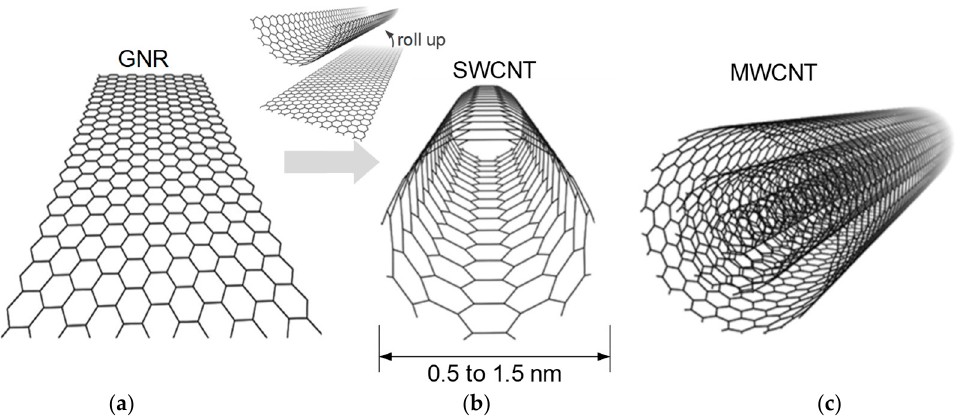
Figure 1. Schematics of ( a ) monolayer graphene nanoribbon (GNR), ( b ) single-walled carbon nanotube (SWCNT), and ( c ) multi-walled carbon nanotube (MWCNT). (SWCNT), and ( c ) multi-walled carbon nanotube